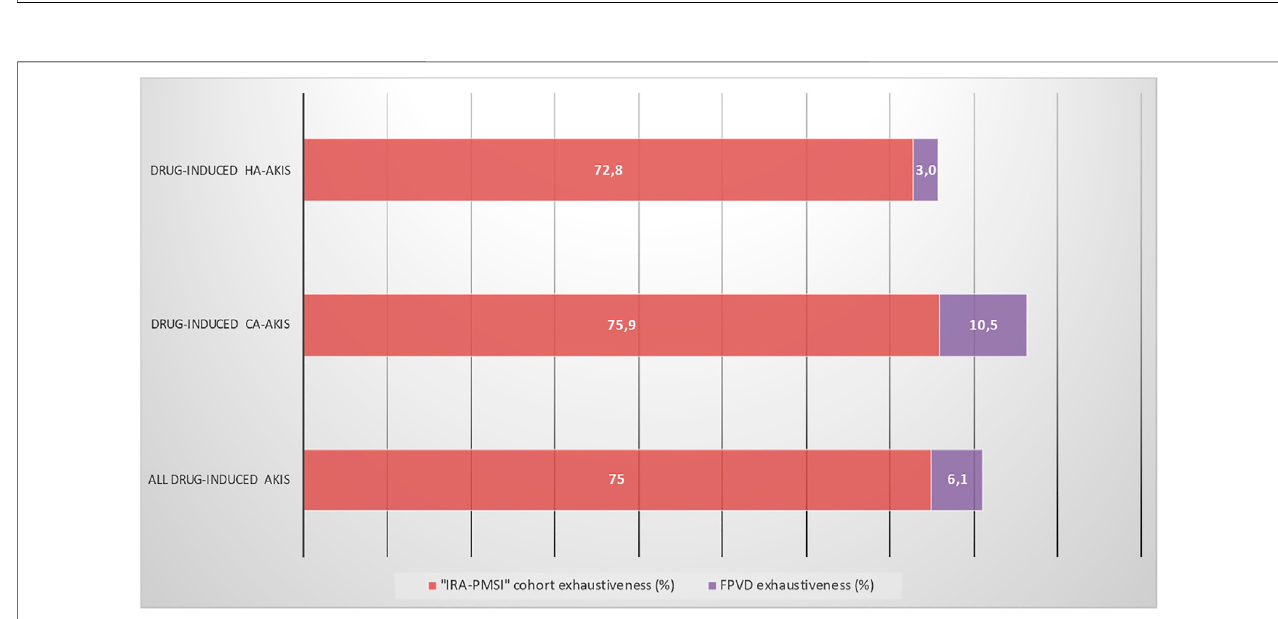
FIGURE 4 | The FPVD noti fi cation rates and estimated proportions for all drug-induced AKIs, as a function of the place of acquisition. AKI, acute kidney injury; CA, community-acquired; FPVD, French national pharmacovigilance database; HA, hospital acquired.